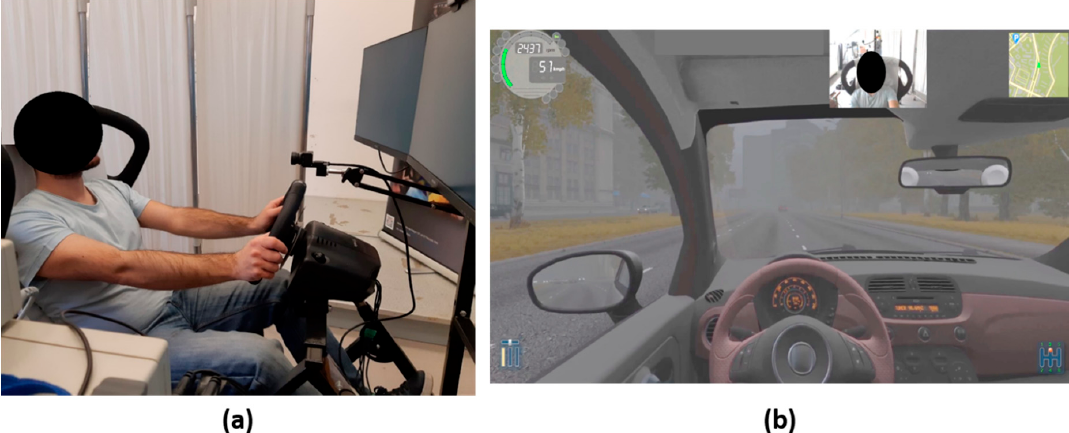
Figure 1. Experimental setting for the proposed study: ( a ) driving simulator, lateral view; ( b ) screenshot of the software used for the driving simulation: City Car Driving [34].